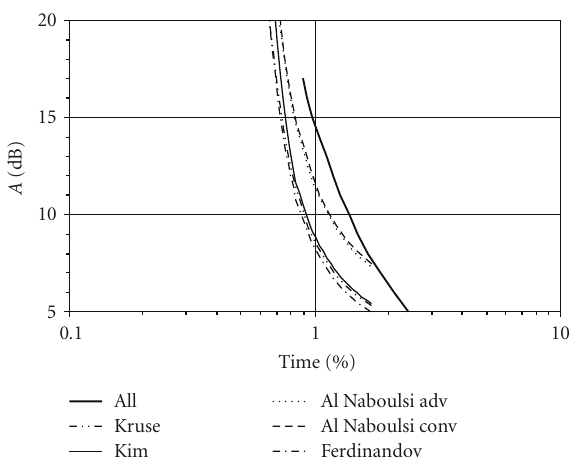
Figure 12: Comparison of the CDs of measured attenuation due to all the hydrometeors combined with the calculated attenuation from visibility data based on the measured visibility distribution.